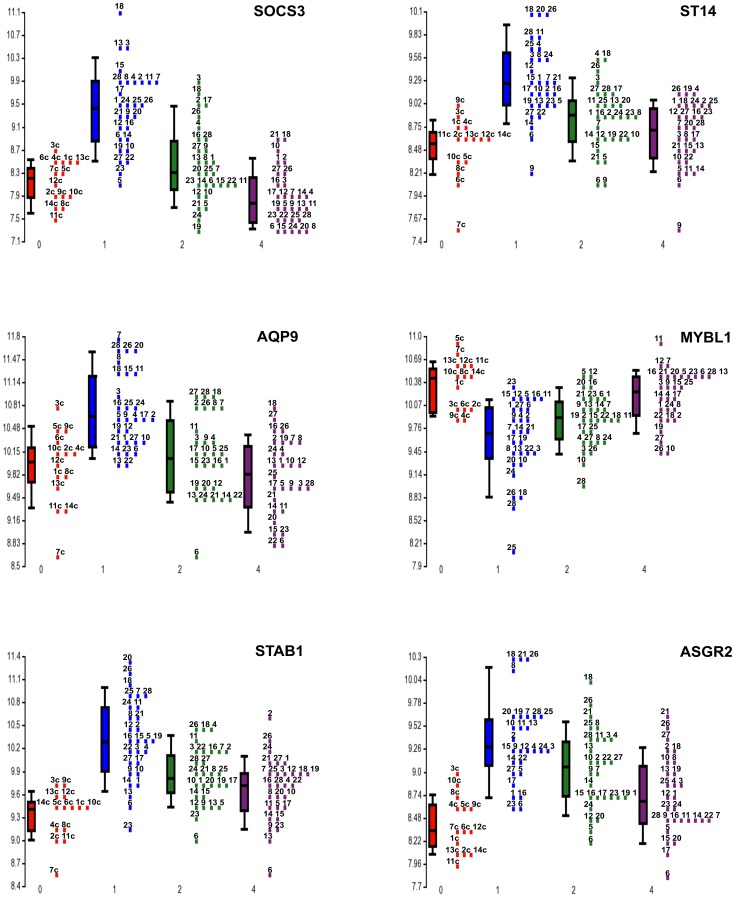
Expression data from microarray experiments for chosen genes.The y-axis represents the log2 normalized intensity of the gene and the x-axis represents analyzed groups. The line inside the box and whiskers represents the median of the samples in a group. Points present relative expression levels in individual patients at admission (blue), at discharge (green), 6 month after MI (violet) and from control group (red). Numbers indicate the coded identity of a particular patient. SOCS3– suppressor of cytokine signaling 3; ST14– MT-SP1/matriptase; AQP 9– aquaporin 9; MYBL1– v-myb myeloblastosis viral oncogene homolog (avian)-like 1; STAB1– stabilin 1; ASGR2– asialoglycoprotein receptor 2.